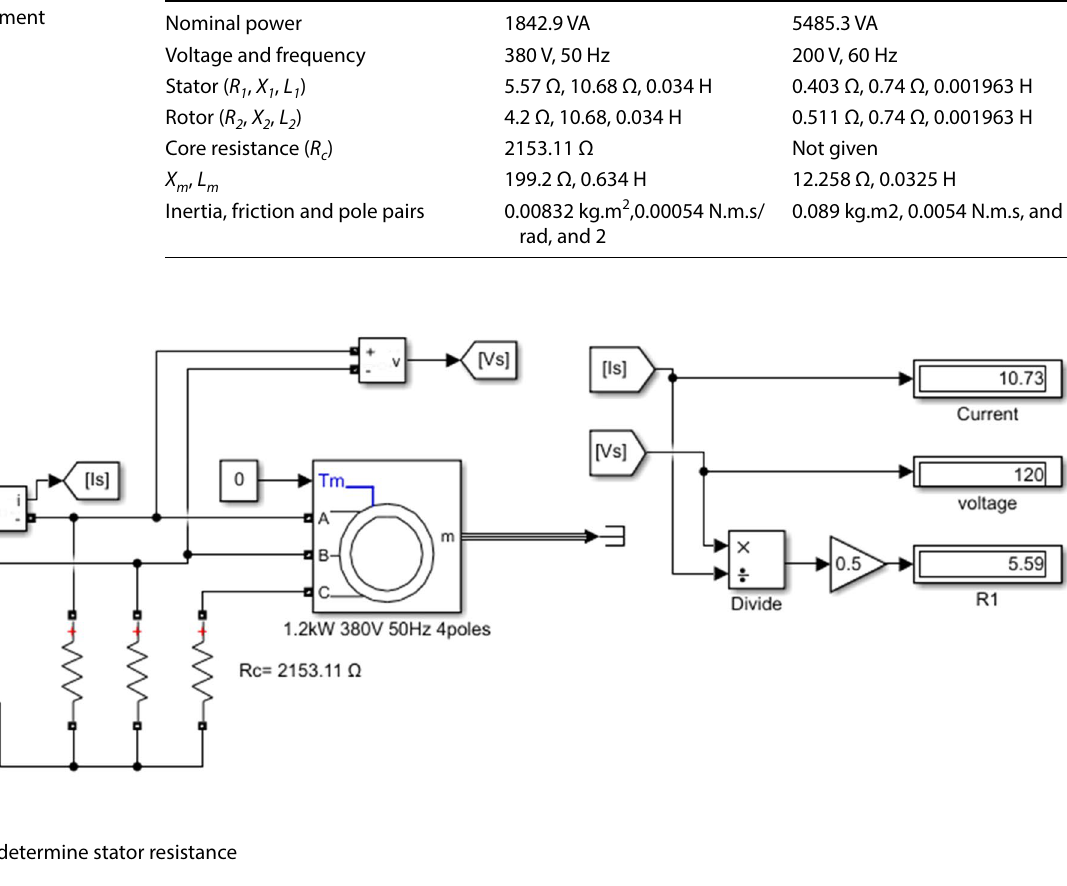
Table 2 Squirrel-cage IM parameters obtained from laboratory experiment